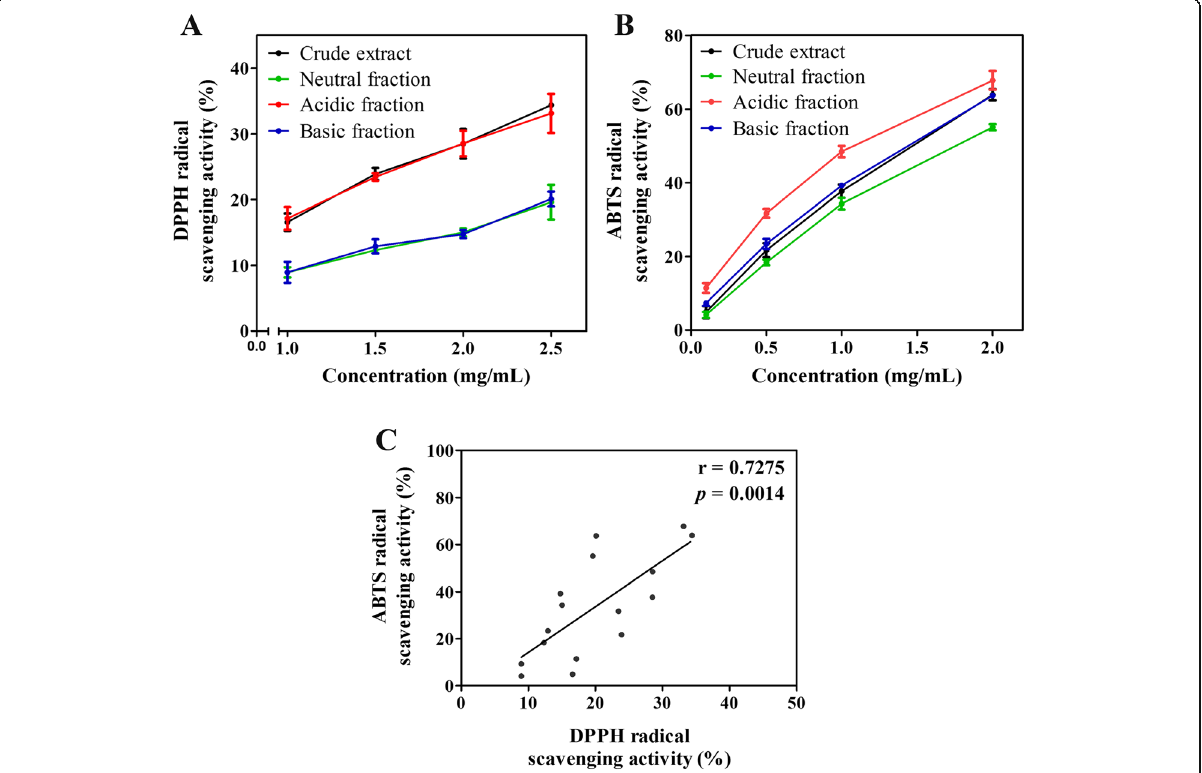
Fig. 3 The dose-response scavenging effects of the crude ethanolic extract of S. asper leaves and its fractions on a DPPH and b ABTS free radicals. Data are expressed as means ± SD of 3 – 7 replicates. c Pearson ’ s correlation analysis between DPPH and ABTS scavenging activities based on mean values of all samples